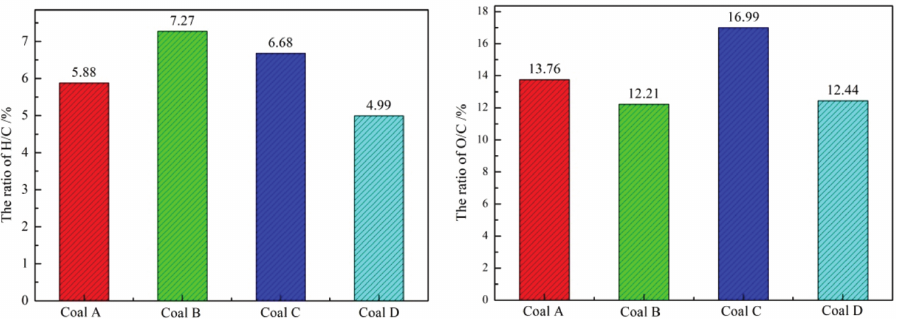
Figure 3: H/C ratio and O/C ratio of lump